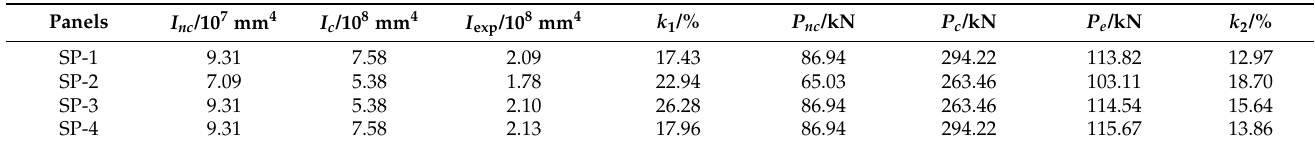
Table 7. Calculation results of composite degrees of